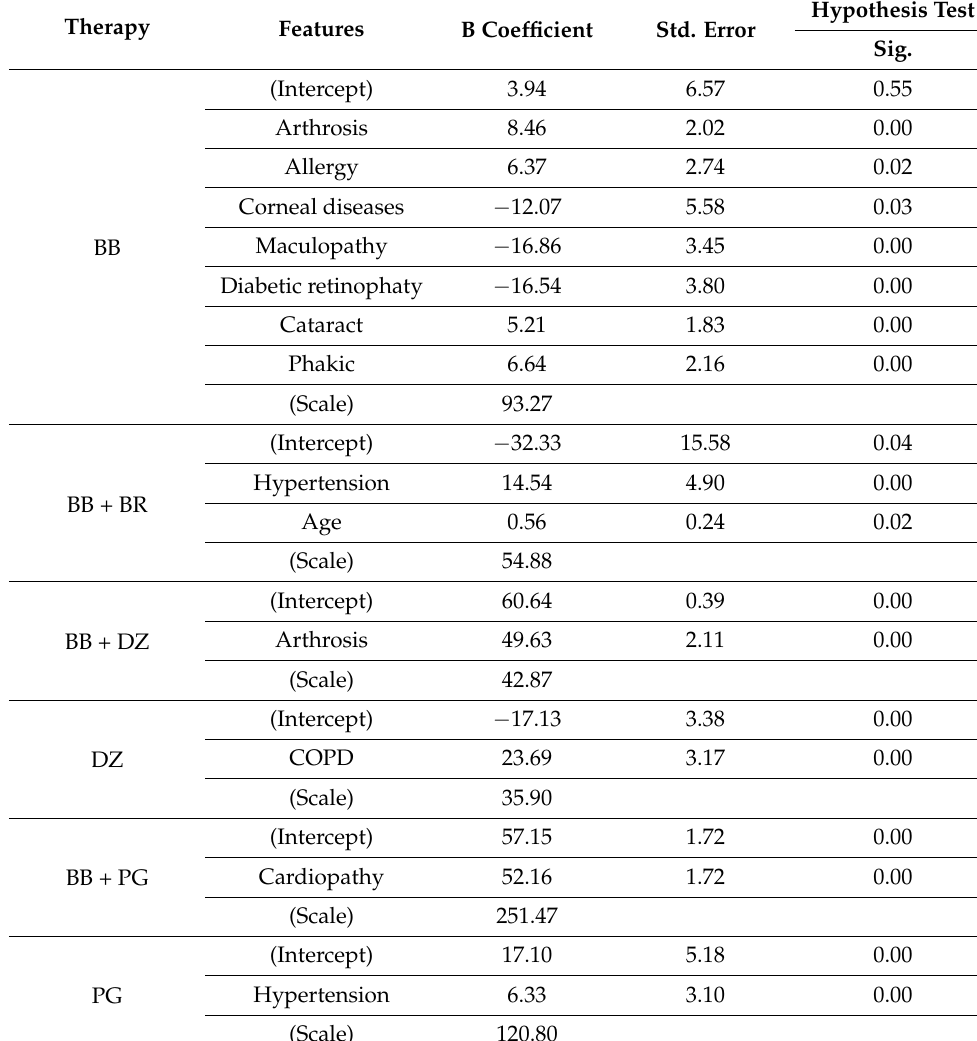
Table 5. Regression models for the therapy duration in the sample stratified according to the type of